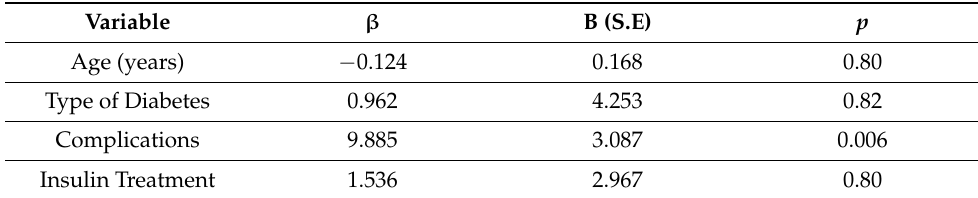
Table 5. Multivariant regression analysis for sick leave of diabetic patients adjusted for age, HbA1c, type of treatment and